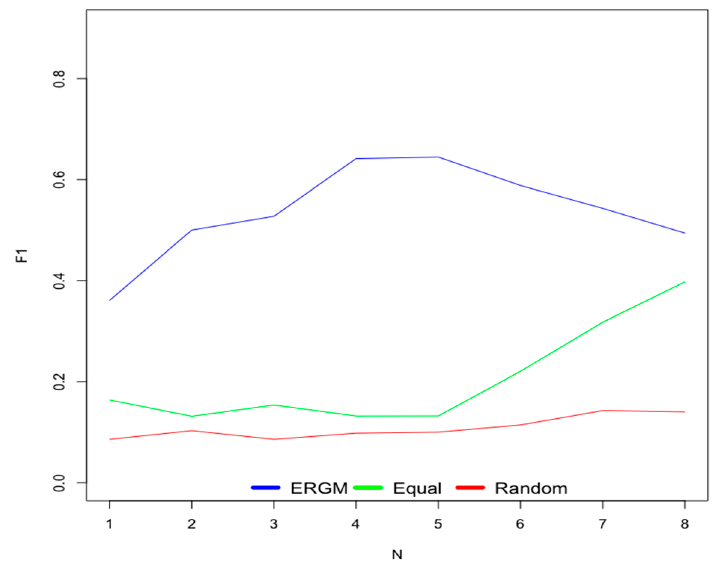
Figure 10. 𝐹 (cid:2869) for old users. Figure 10. F 1 for old